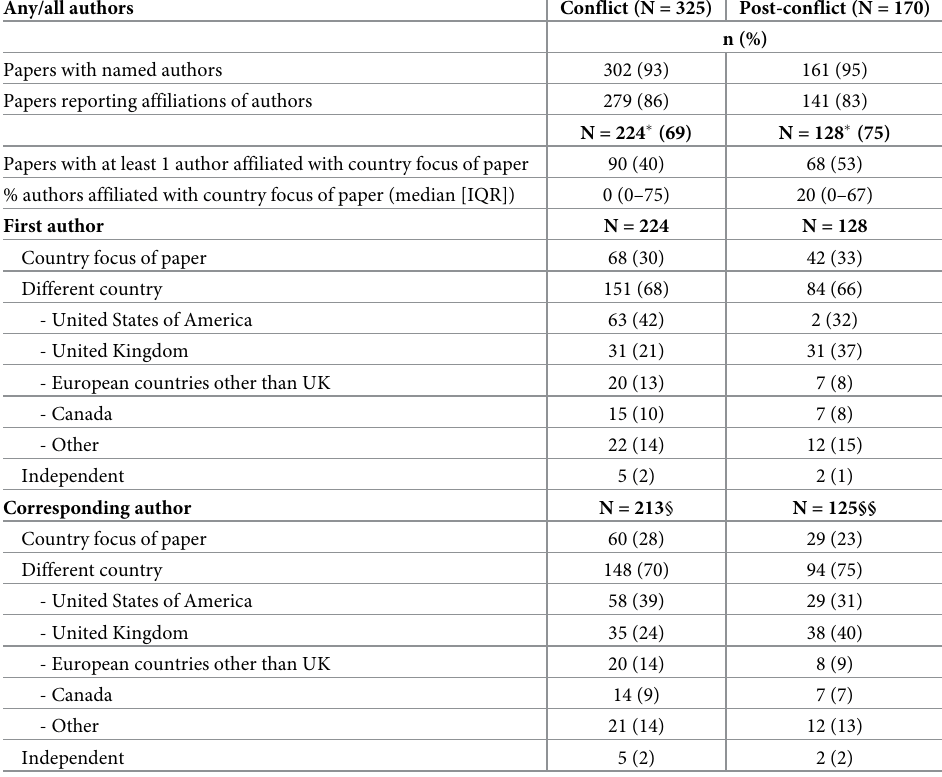
Table 2. Characteristics of authors of the included papers in conflict (N = 325) and post-conflict (N = 170) settings.